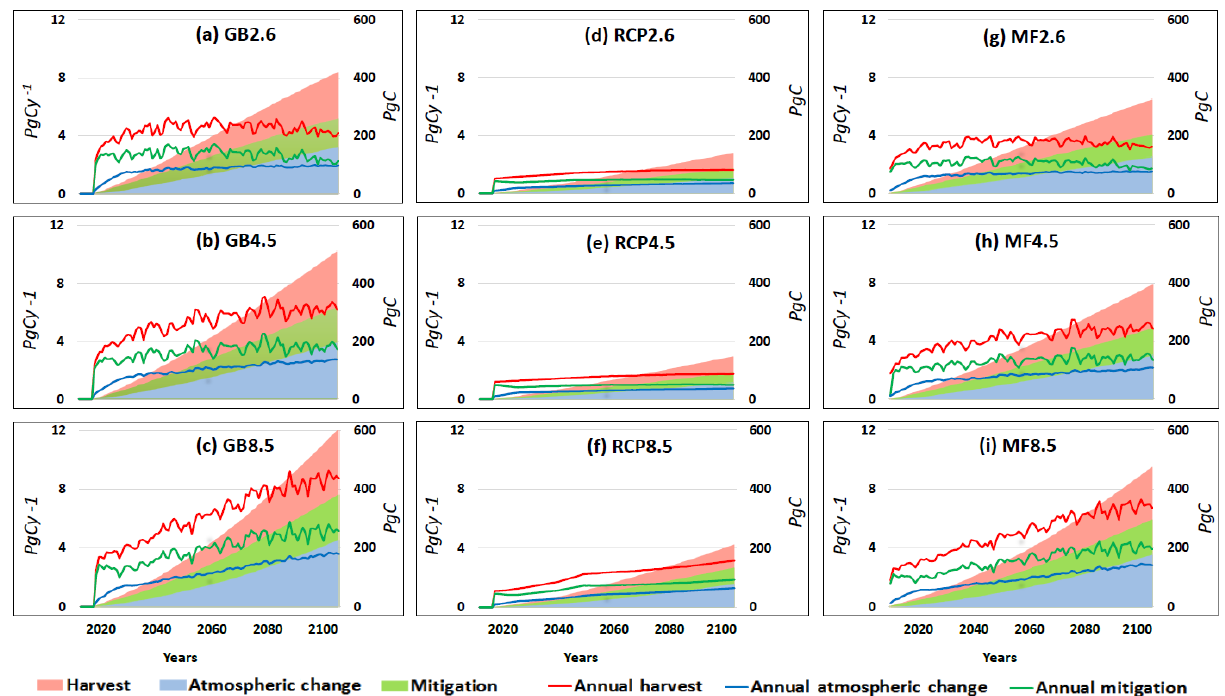
Figure 4. Net mitigation potentials from the growth potential under the growth-based harvesting rule (GB) ( a, b, c ), Representative Concen- tration Pathways’ (RCP) harvest ( d, e, f ), and GB harvest limited to managed forest area (MF) ( g, h, i ). Left axes show the annual carbon fluxes due to harvested material and product decay changing atmospheric CO 2 concentration, and the mitigation potential of wood products as the difference of both. Right axes accumulate the annual figures over time.